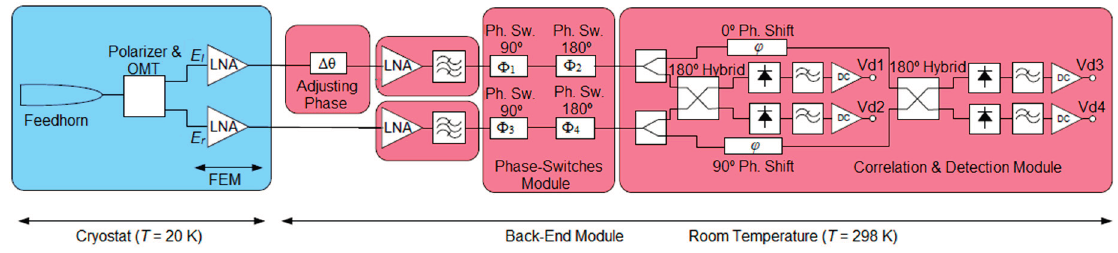
Figure 1. TGI polarimeter block